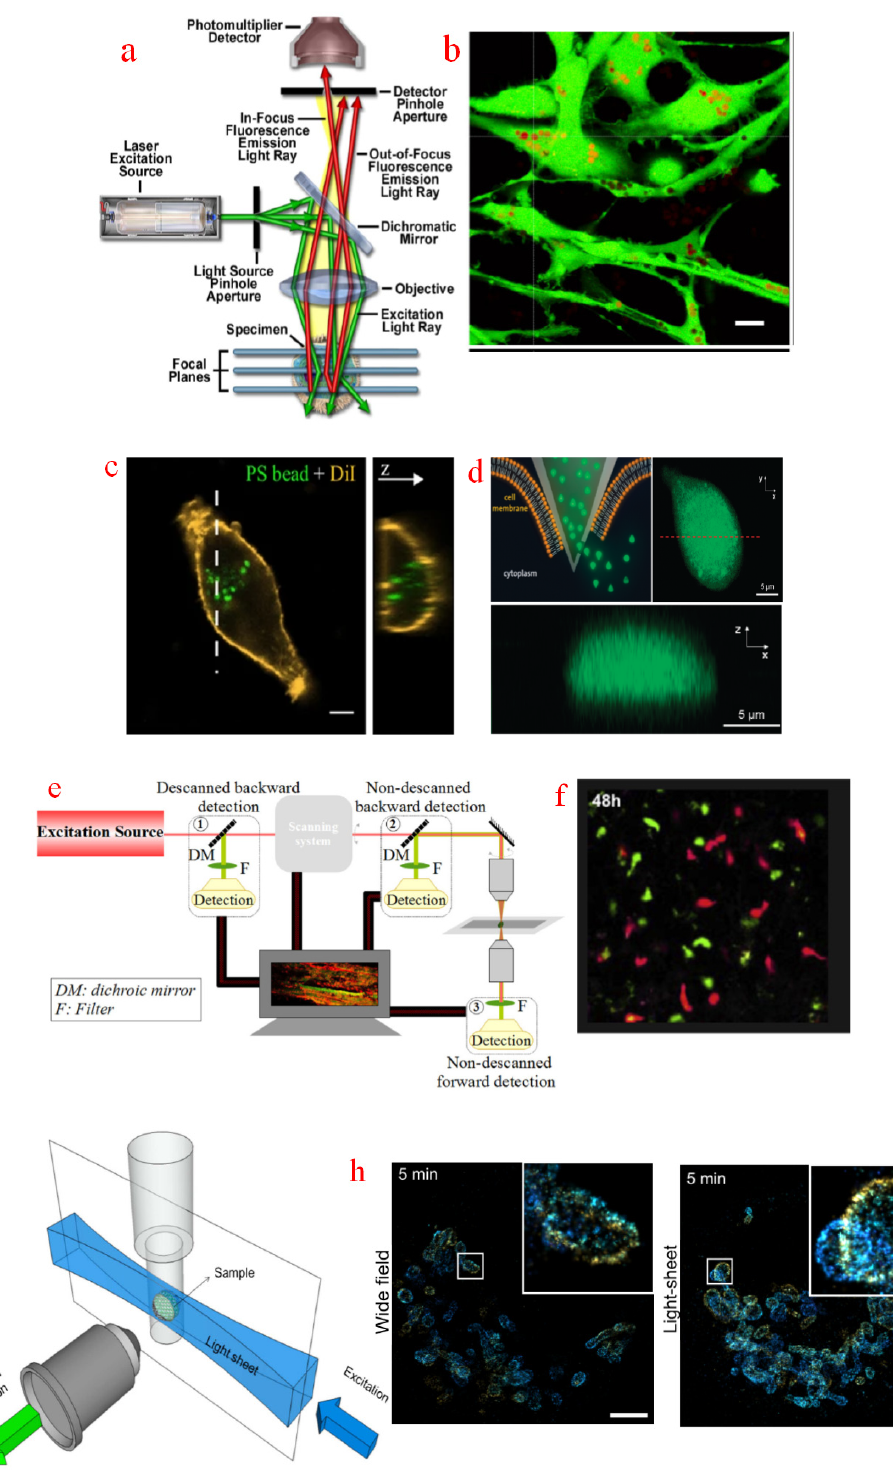
Figure 1. State-of-the-art microscopes and their applications in biological imaging. ( a ) Schematic of CFM. Adapted with permission from Reference [43]; ( b ) CFM-sampled images of HeLa cells (green) and porous CaCO 3 particles (yellow). Adapted by with permission from Reference [44]; ( c ) Three-dimensional distribution of polystyrene beads in human hepatocellular carcinoma (HCC)